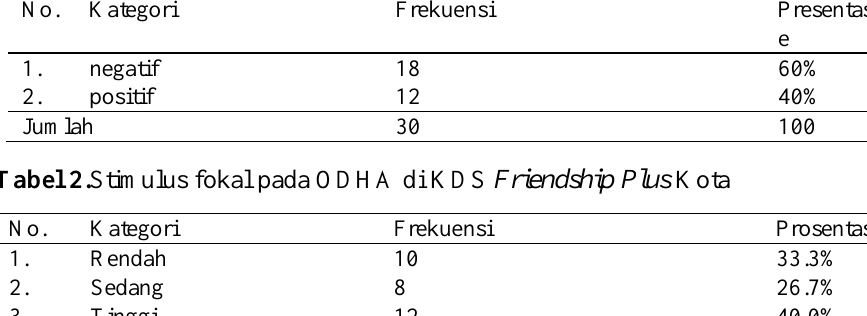
Tabel 2. Stimulus fokal pada ODHA di KDS Friendship Plus Kota